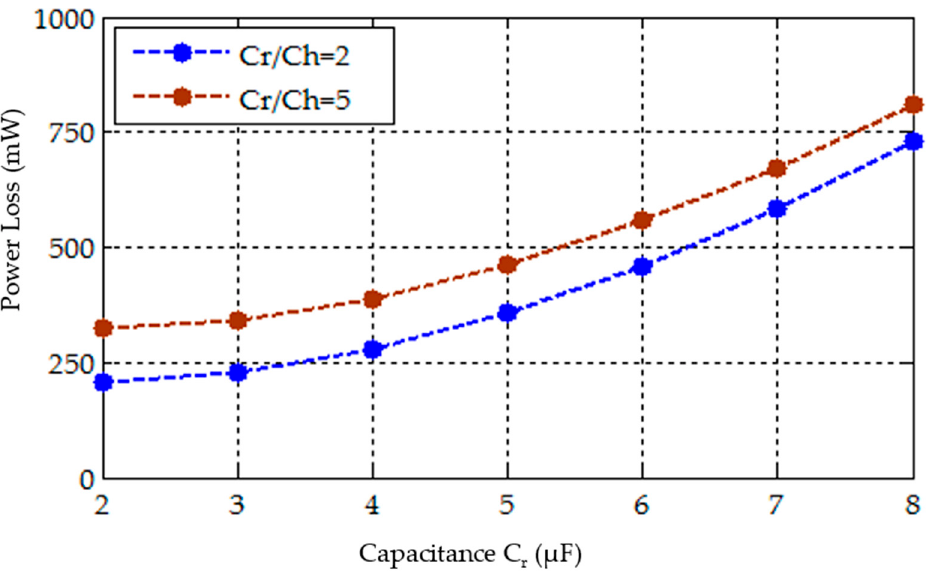
Figure 8. Damping loss variation with capacitance ratio.